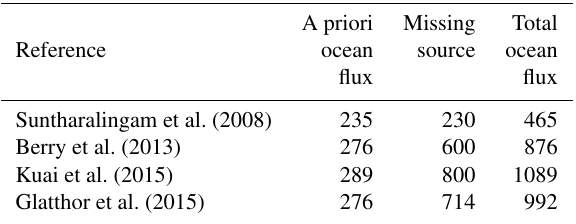
Table 1. Missing source estimates derived from top-down ap- proaches: the listed studies used an increased vegetation sink and an a priori direct and indirect ocean flux to estimate the magnitude of the missing source. Assigning the missing source to oceanic emis- sions results in the total ocean flux listed here. Fluxes are given in GgS per